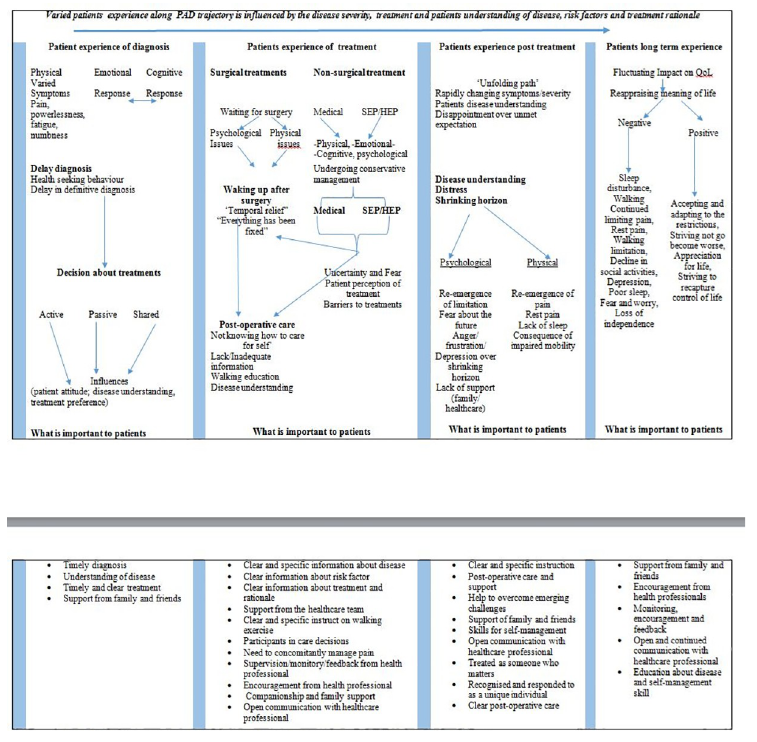
Fig 2. Framework synthesis of patients experiences of living with peripheral arterial